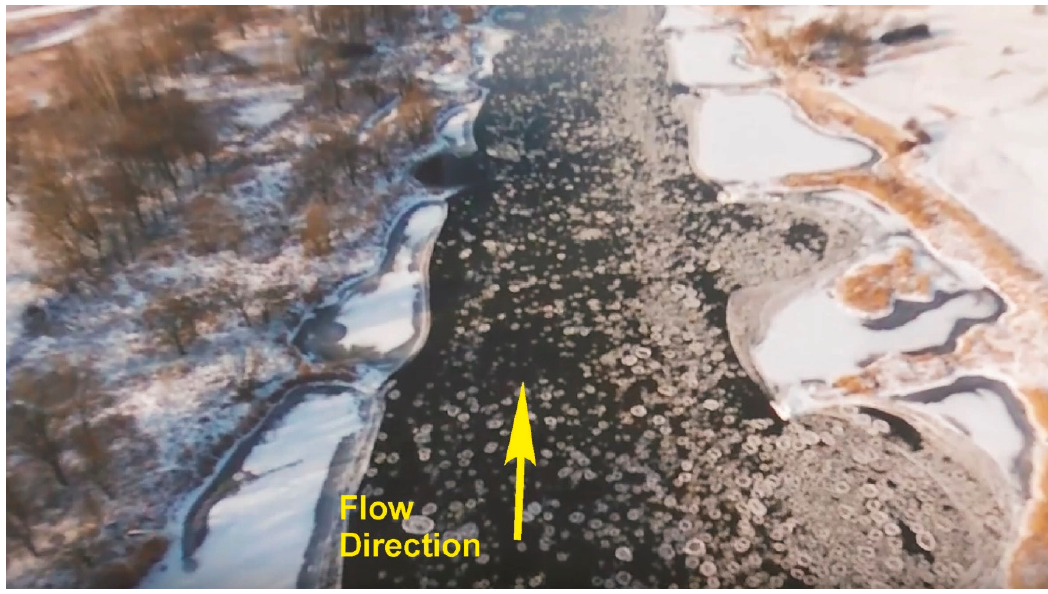
Figure 7. Aerial photograph showing ice movement on 13 January 2017 during windless weather, with an average flow of 150 m 3 /s on the Odra River upstream of Cigacice bend.